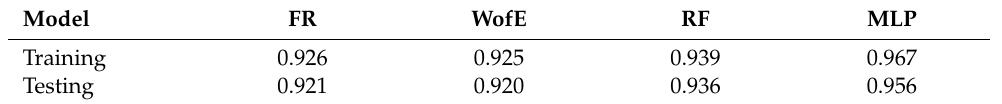
Table 3. AUC value for flood susceptibility through FR, WofE, and MLP. Model FR